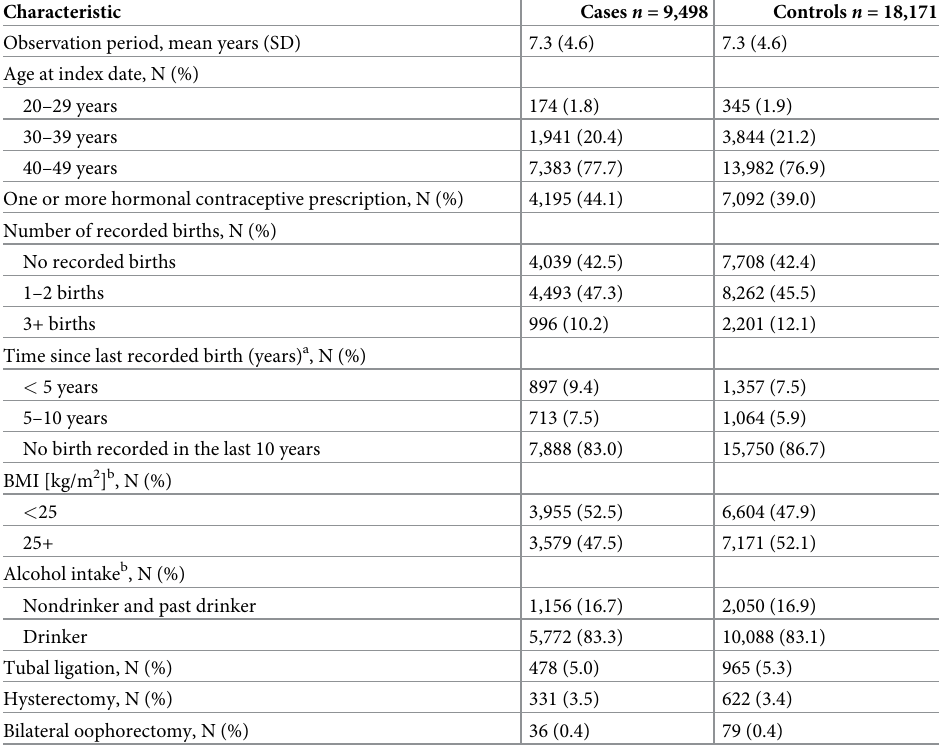
Table 1. Characteristics of cases and controls in the CPRD